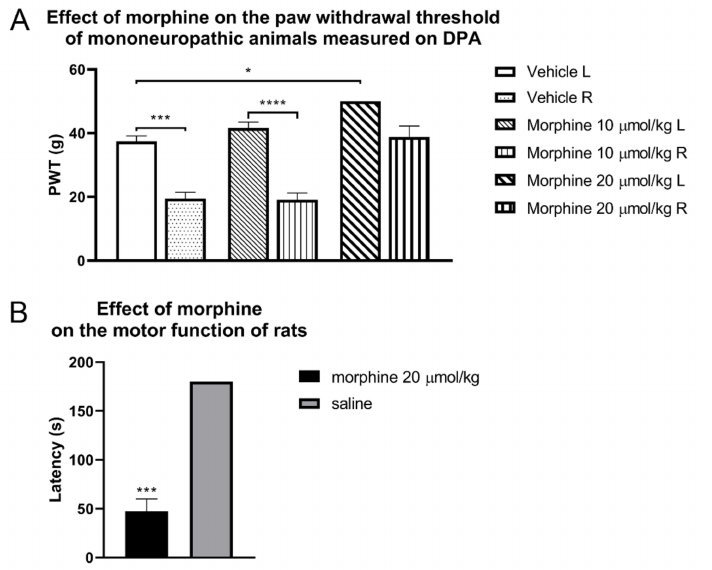
Figure 1. ( A ) The analgesic effect of morphine measured on a dynamic plantar aesthesiometer (DPA) test at 30 min, after s.c. administration to mononeuropathic animals. Columns represent the paw withdrawal threshold of the animals in grams ± S.E.M. Asterisks indicate the significant differences between treatment groups or operated (R) and non-operated (L) hind paws (* p < 0.05; *** p < 0.001 and **** p < 0.0001). Statistical differences were determined with one-way ANOVA and Tukey post-hoc test. Data represent means ± S.E.M (n = 5–12 per group). (Kar á di, D. Á .; Al-Khrasani, M.; unpublished data). ( B ) Effect of the systemic administration of morphine to the motor function of rats. Columns represent the time latency of the animals in sec ± S.E.M. at 30 min post-treatment in the rotarod test. Asterisks indicate the significant differences compared to the saline group (one-way ANOVA, Newman–Keuls post-hoc test; *** p < 0.001). In each treatment group, 4–7 animals were used. These results were adopted from our previous work